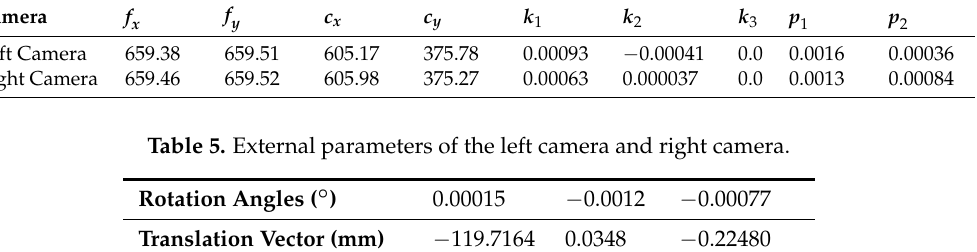
Table 4. Internal parameters of the left and right camera. The units of f x , f y , c x , and c y are pixels. Camera